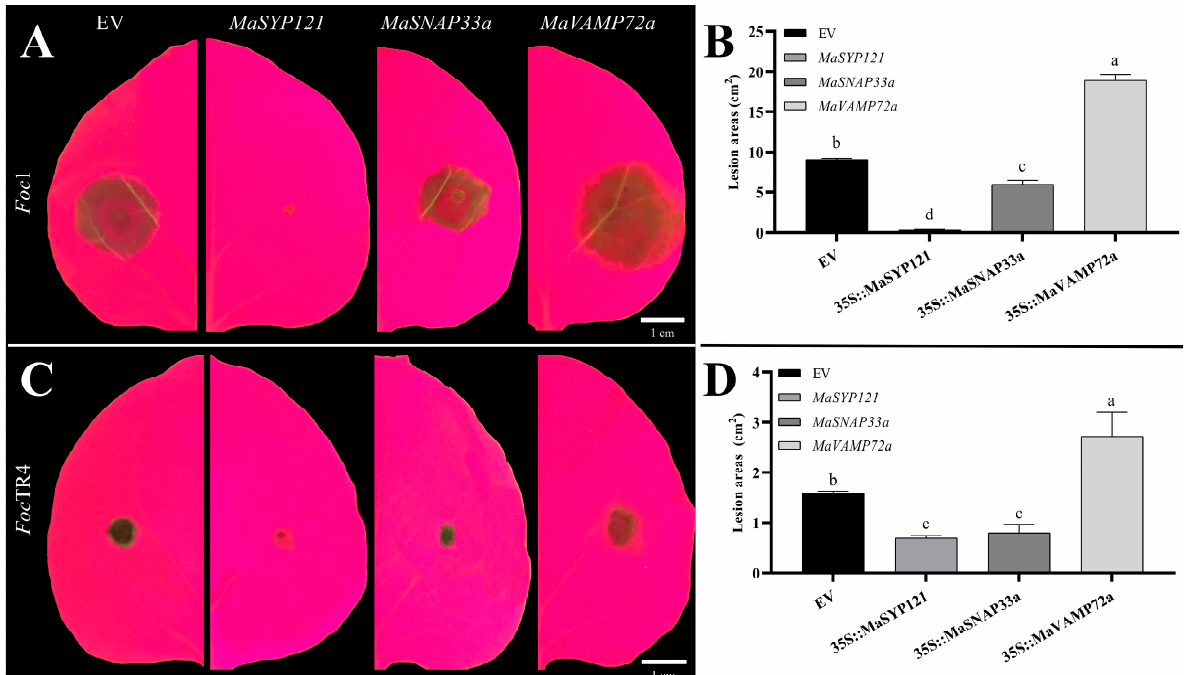
Figure 9. The influence of MaSYP121 , MaSNAP33a and MaVAMP72a transient overexpression on Foc 1 and Foc TR4 infection in N. benthamiana leaves. ( A , B ): lesions in the N. benthamiana leaves inoculated with Foc 1 (at 48 h post inoculation) and Foc TR4 (at 72 h post inoculation). ( C , D ): lesion areas caused by Foc 1 and Foc TR4 inoculation in the N. benthamiana leaves. Different lowercase letters above the columns represent significant differences at p < 0.05 level. EV: empty vector control.